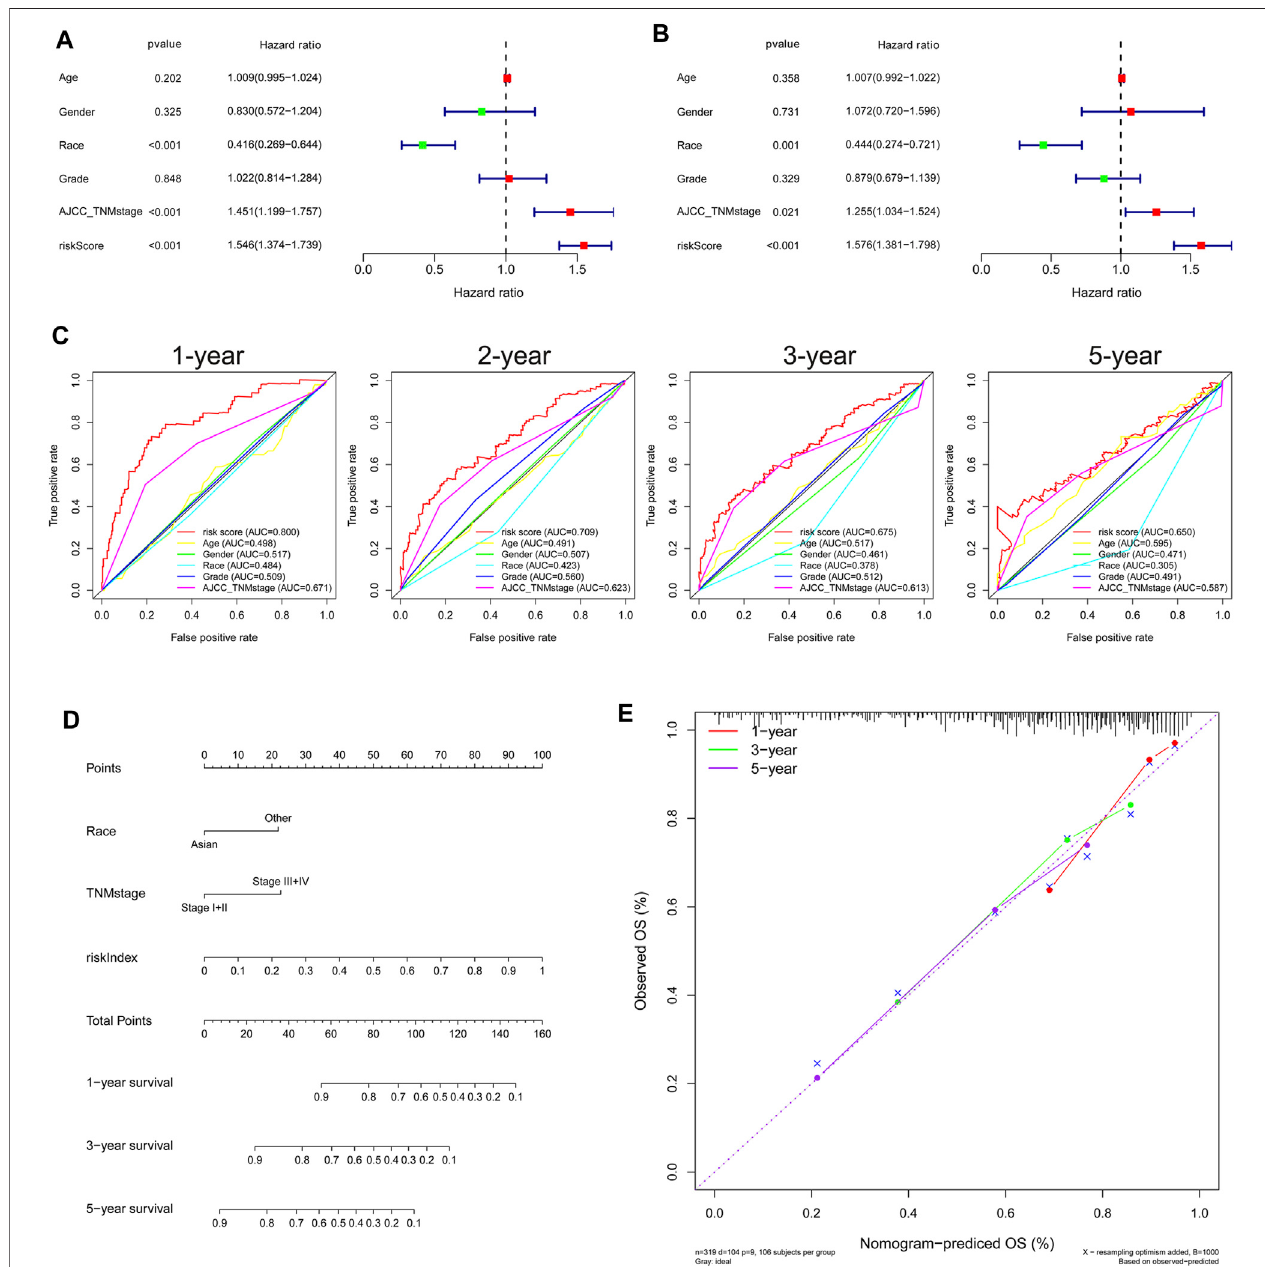
FIGURE 3 | Independent prognostic role of gene signature in the TCGA Cohort. (A) Univariate and (B) multivariate Cox regression analysis of the associations between risk index (RI) and clinical parameters and OS. (C) ROC curve for comparing the prognostic accuracy of RI, age, gender, race, grade, and TNM stage. (D) Nomogram for predicting 1-, 3-, and 5-year survival. (E) Calibration curves of nomogram on consistency between predicted and observed 1-, 3-, and 5-year survival.